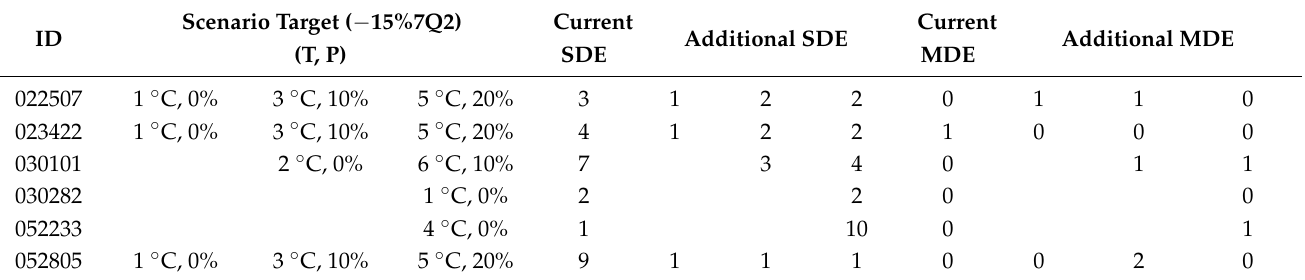
Table 3. Scenarios of low flow target conditions ( − 15% 7Q2) and dry events. The additional SDE and MDE columns are the additional number of events concerning the number of current events. The Scenario Target ( − 15%7Q2) column shows the scenarios from the closest to the farthest, from left to right, in which this threshold could be reached. SDE: short dry events. MDE: medium dry events.